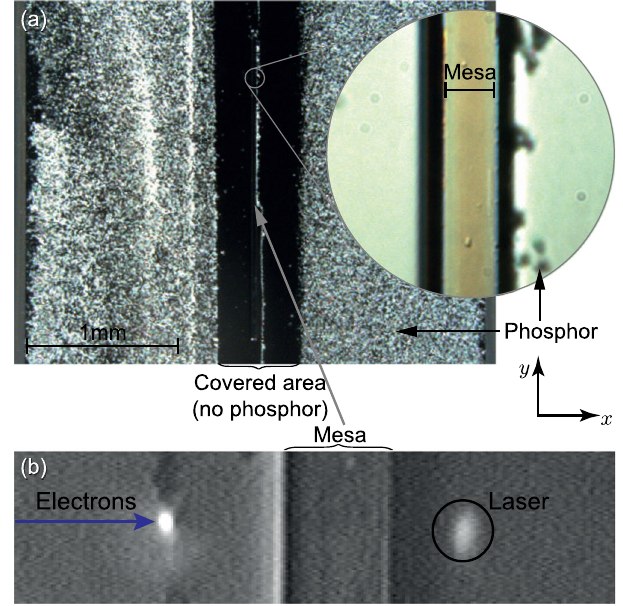
FIG. 5 (color online). (a) Microscope image of the phosphor- coated grating with closeup of the mesa. The phosphor (white grains) covers the substrate except for a 0.5 mm wide area around the mesa, which was masked during the coating procedure. For coarse alignment of the laser focus we use phosphor grains that have by chance accumulated right next to the mesa inside the otherwise phosphor-free region. (b) Image of the phosphor- coated grating (mesa in the center) in the experiment recorded with the microscope objective (Fig. 2). A single grain of phosphor is illuminated by the electron beam (white spot, left). We vertically overlap the laser focus (right). In this alignment procedure the grating is slightly tilted around the y axis, such that the electron beam can approach the bottom of the mesa structure without being clipped at the edge of the